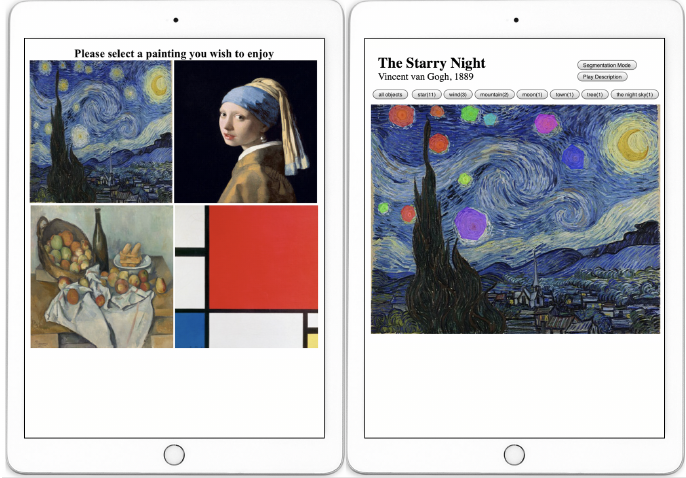
Figure 3. User interface prototype with two interaction modes: Overview ( left ) and Exploration ( right ). As for the Exploration Mode example, star is selected as object of interest, highlighted in various colors.